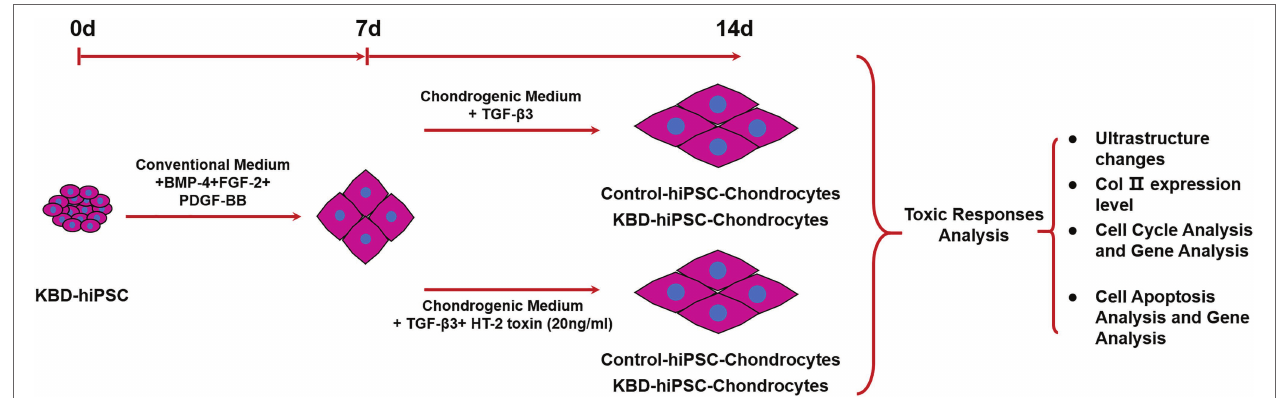
FIGURE 1 | Study scheme of this study. Both the control hiPSCs and the KBD hiPSCs were differentiated into chondrocytes. In order to test the adverse effect of HT-2 toxin on the chondrogenesis of the control hiPSCs and the KBD hiPSCs, the hiPSC chondrocytes differentiated for 7 days were exposed to HT-2 toxin (20 ng/ml) for 7 days before ultrastructure changes, chondrogenesis, cell cycle, and cell apoptosis were analyzed. hiPSCs, human induced pluripotent stem cells; KBD, Kashin–Beck